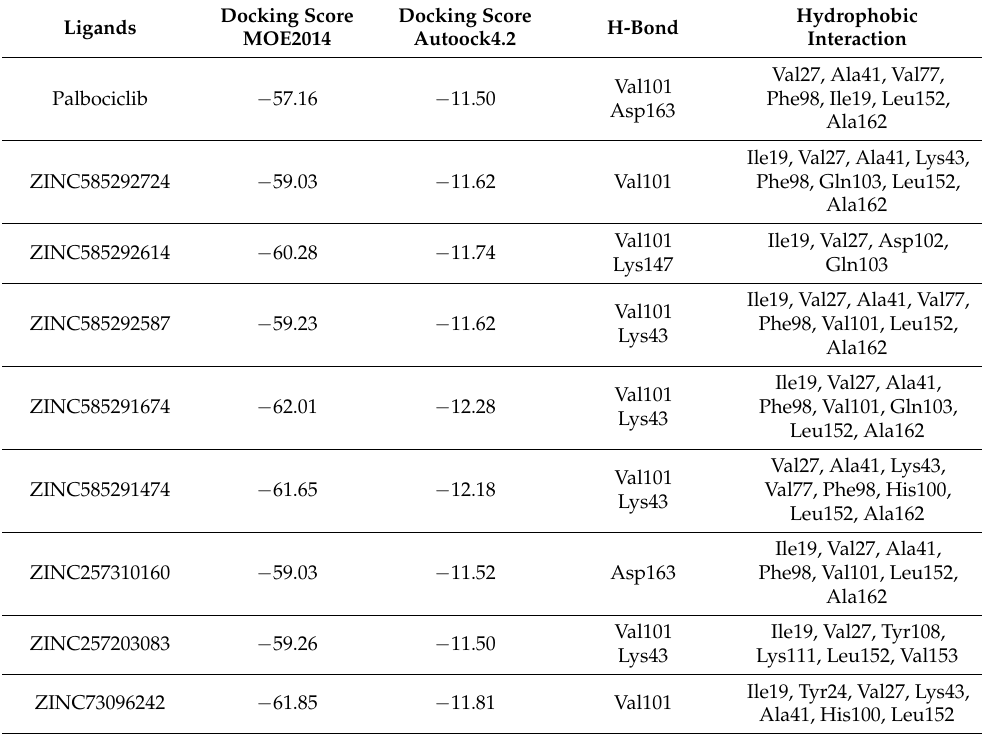
Table 3. CDK6–ligand interactions recorded during